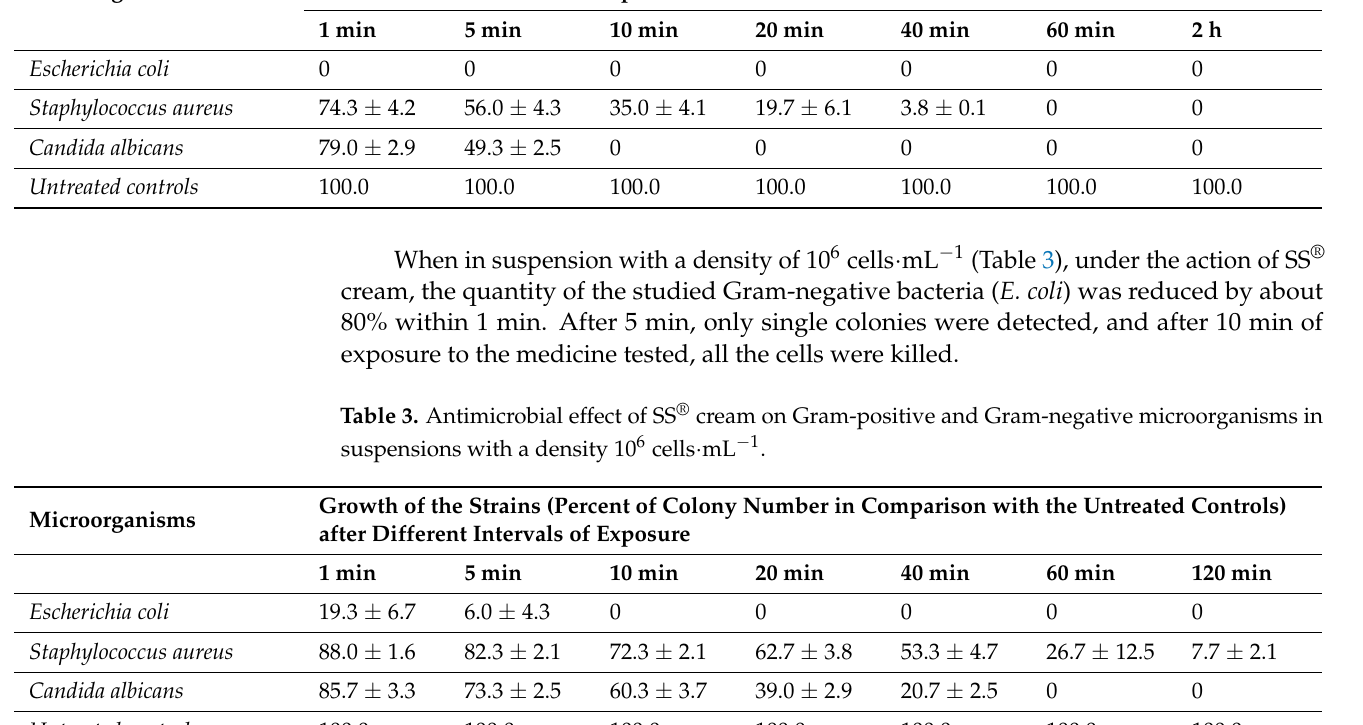
Table 2. Antimicrobial effect of SS ® cream on Gram-positive and Gram-negative microorganisms in suspensions with a density 10 4 cells · mL − 1 .